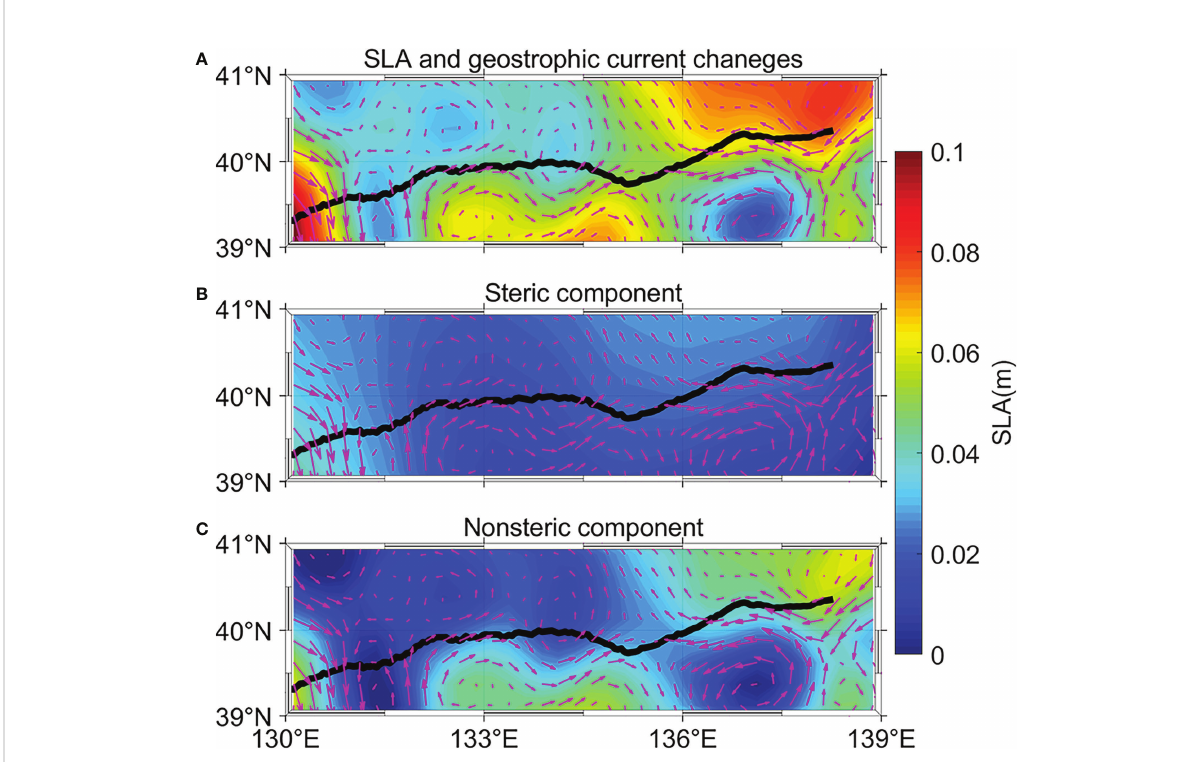
FIGURE 9 (A) Decadal change in the SLA between the time periods 1993 – 2002 and 2011 – 2020 (the latter minus the former; shading: SLA, unit: m). (B, C) Same as (A) but for the results of steric and non-steric components. Magenta vectors are the geostrophic currents decadal changes, duplicated from Figure